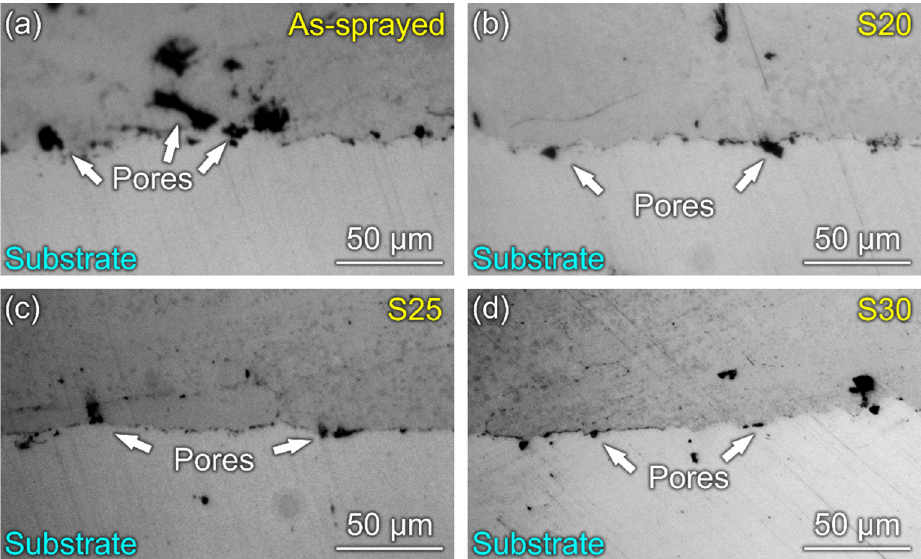
Figure 2. Optical images for the microstructural features of coating/substrate interfaces for different samples: ( a ) as-sprayed, ( b ) S20, ( c ) S25, and ( d ) S30 coating samples. S20, S25, and S30 indicate the as-sprayed NiCrBSi coatings remelted at 20 kW, 25 kW, and 30 kW. The pores in the images are representative but not quantitative.